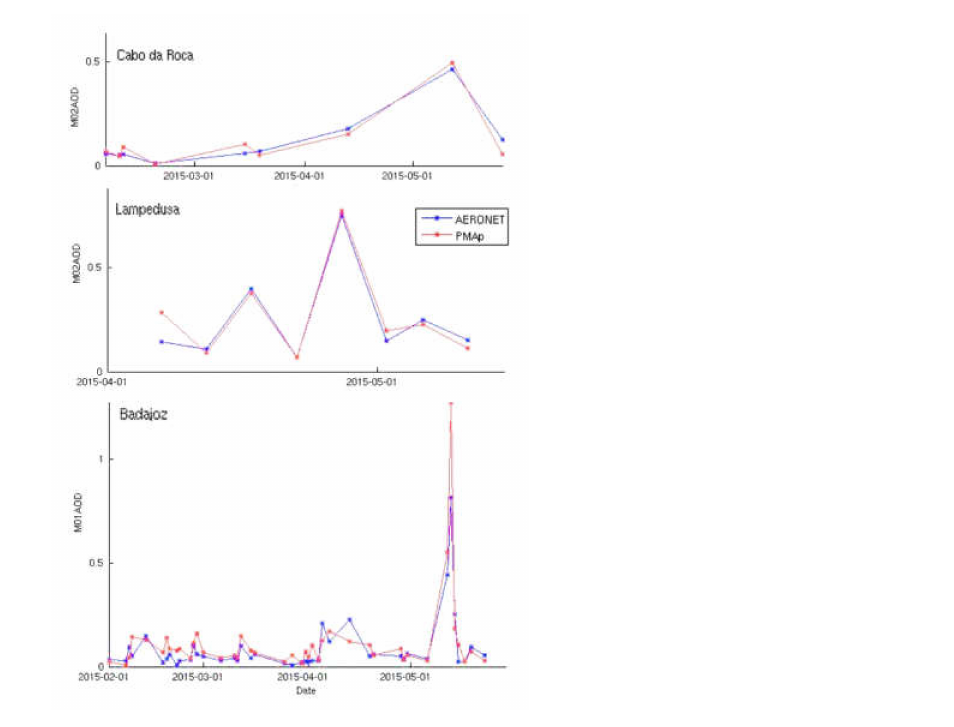
Figure 12. Time series of the AOD at 550 nm for validation period 2 compared to the AOD retrieved from Metop-B and for 3 AERONET sites: Cabo da Roca, Lampedusa, and